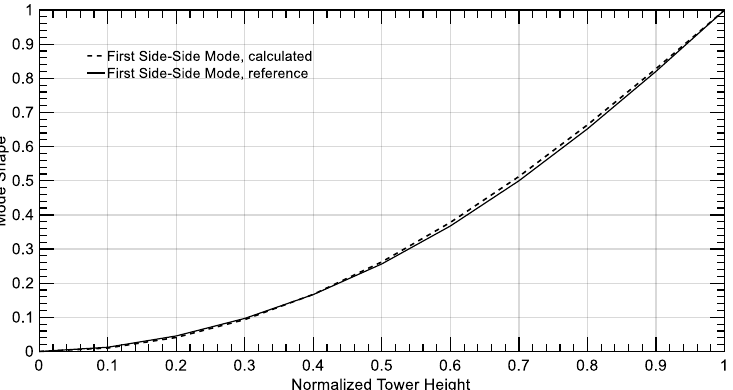
Figure 9. Tower side-side mode shape: single rotor configuration.